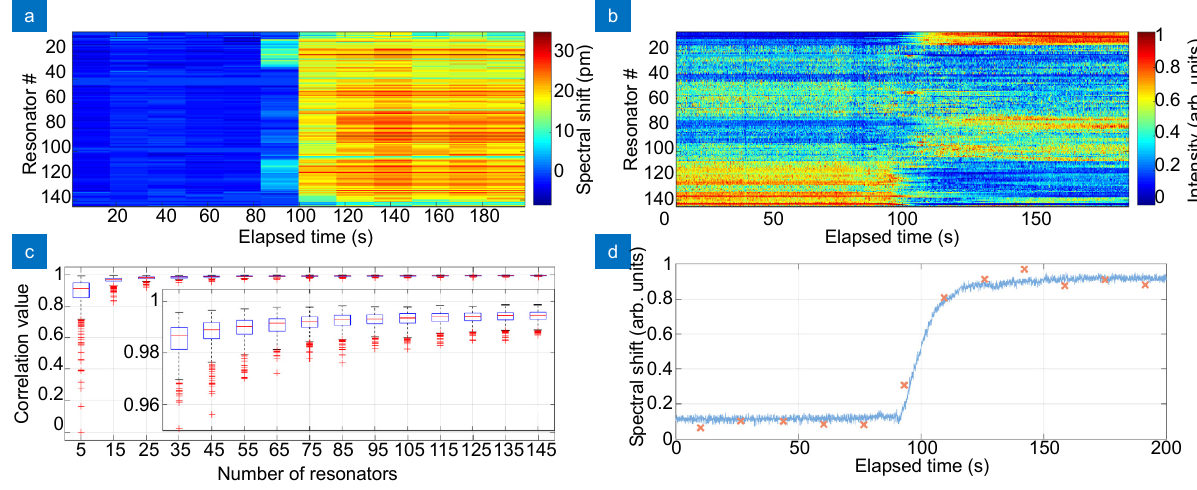
Fig. 3 | Comparison of the experimental data collected in the laser frequency sweeping and the fixed frequency schemes for the same sensor sample under changing ambient refractive index. ( a ) Dynamics of the spectral shift in the frequency sweeping scheme. ( b ) Overview of the radiated intensities collected in the fixed frequency regime. ( c ) Statistics on the correlation values between the dynamics measured in both configurations (frequency sweeping and fixed frequency) with respect to the number of the microcavities in the scope. ( d ) Correlation between the scaled variations calculated in both configurations with respect to the number of the microcavities in the scope (solid line - fixed frequency, dots - sweeping